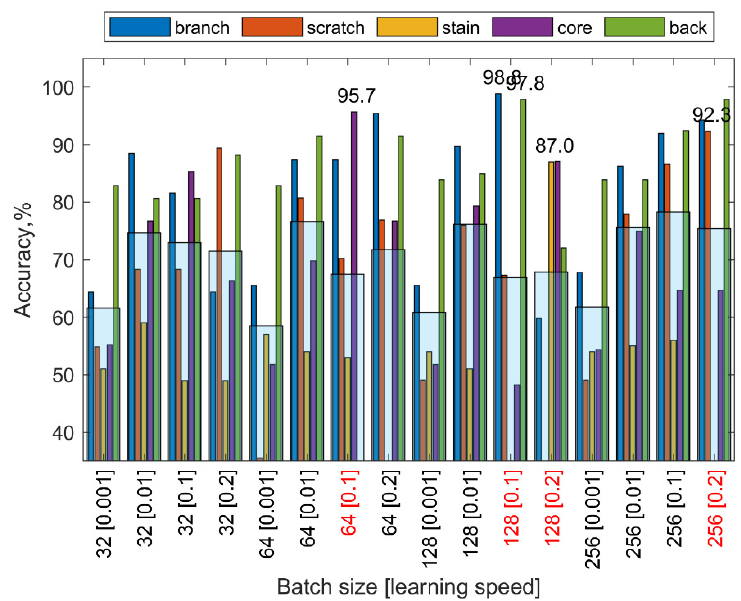
Figure 15. Classification accuracy using the BNInception neural network trained with di ff erent network parameters (batch size and learning speed). The best combinations of parameter values are indicated in